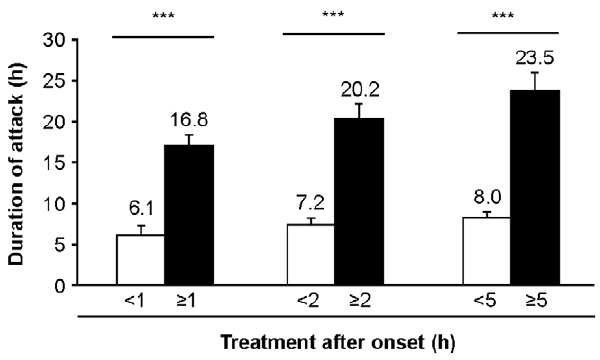
Figure 2. Early treatment reduced mean attack duration. Figure demonstrates the mean duration (time from the start of the attack to the complete resolution of symptoms) of attacks treated before and after each timepoint. n=207 attacks ( , 1 hour, n=80; $ 1 hour, n=127; , 2 hours, n=120; $ 2 hours, n=87; , 5 hours, n=145; $ 5 hours, n=62); all attacks are included at each timepoint; *** p , 0.001.